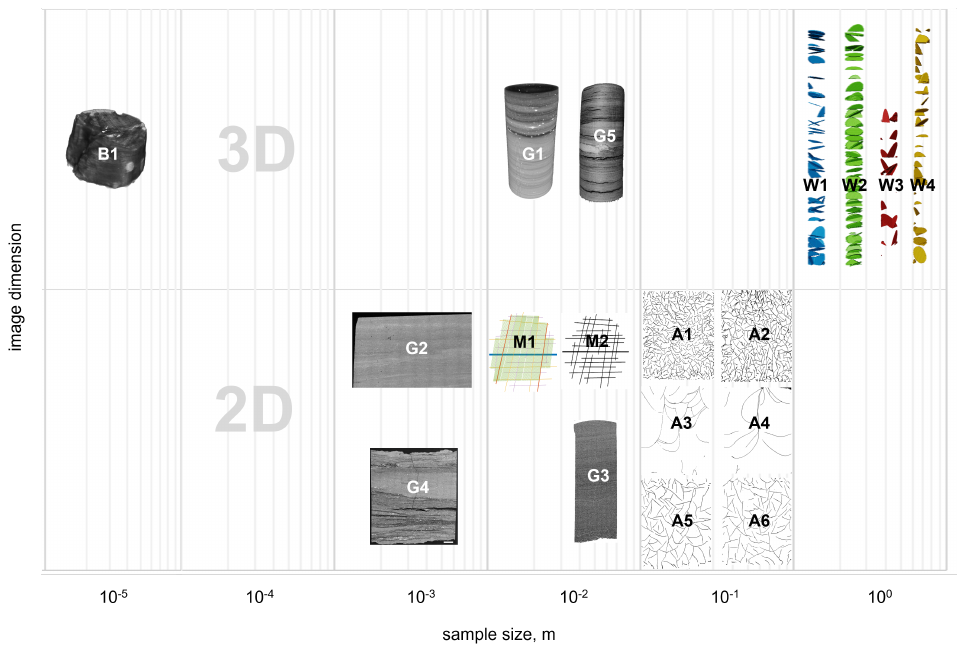
Figure 1. Multimodal, multiscale image dataset. The labels on the images correspond to those listed in Table